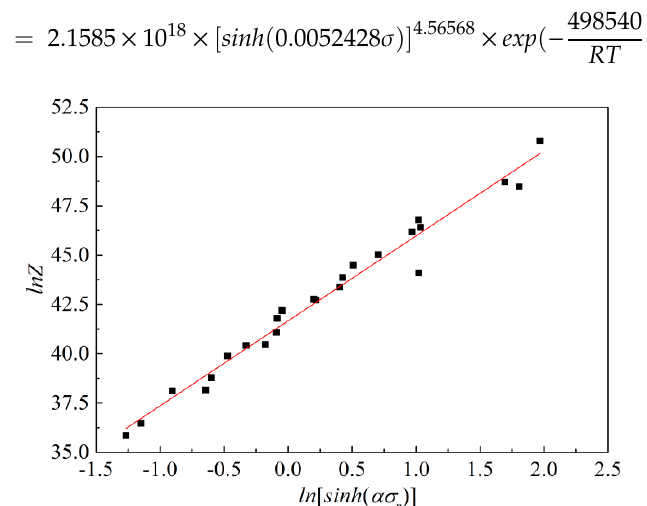
ασ p )] at various strain rates and deformation